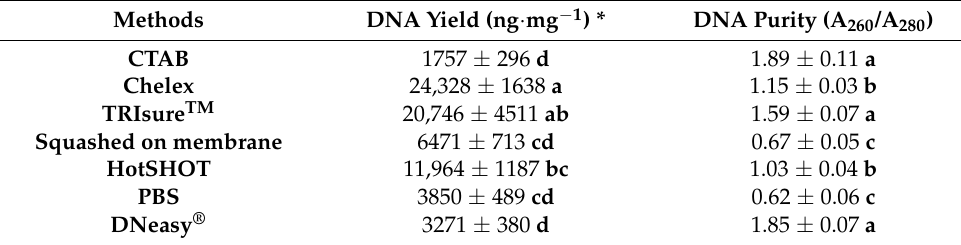
Table 2. Comparison among DNA yield ratios and DNA purity ratios (mean ± SE, n = 14) of seven DNA extraction methods with ground specimen preparation.